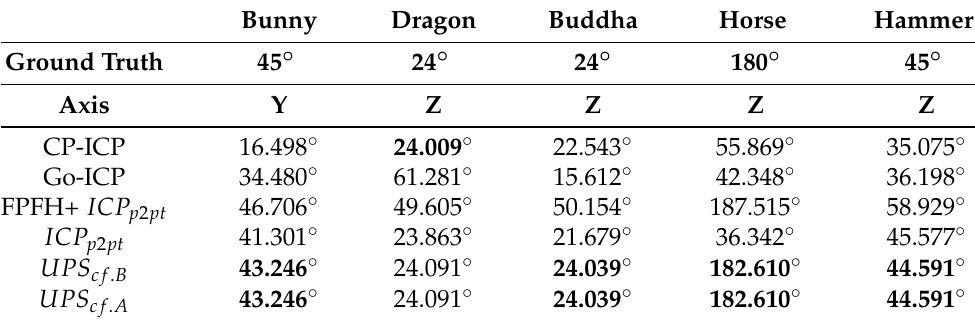
Table 3. Rotation obtained from the point cloud registration under known ground truth. Bunny Dragon Buddha Horse